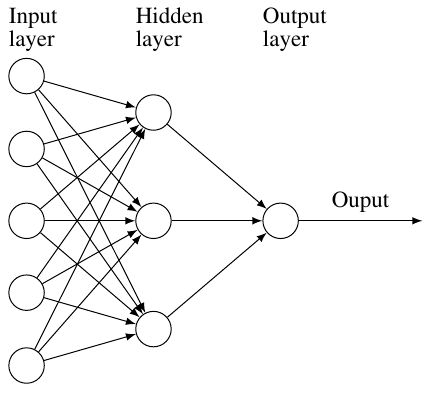
Figure 1. An artificial neural network